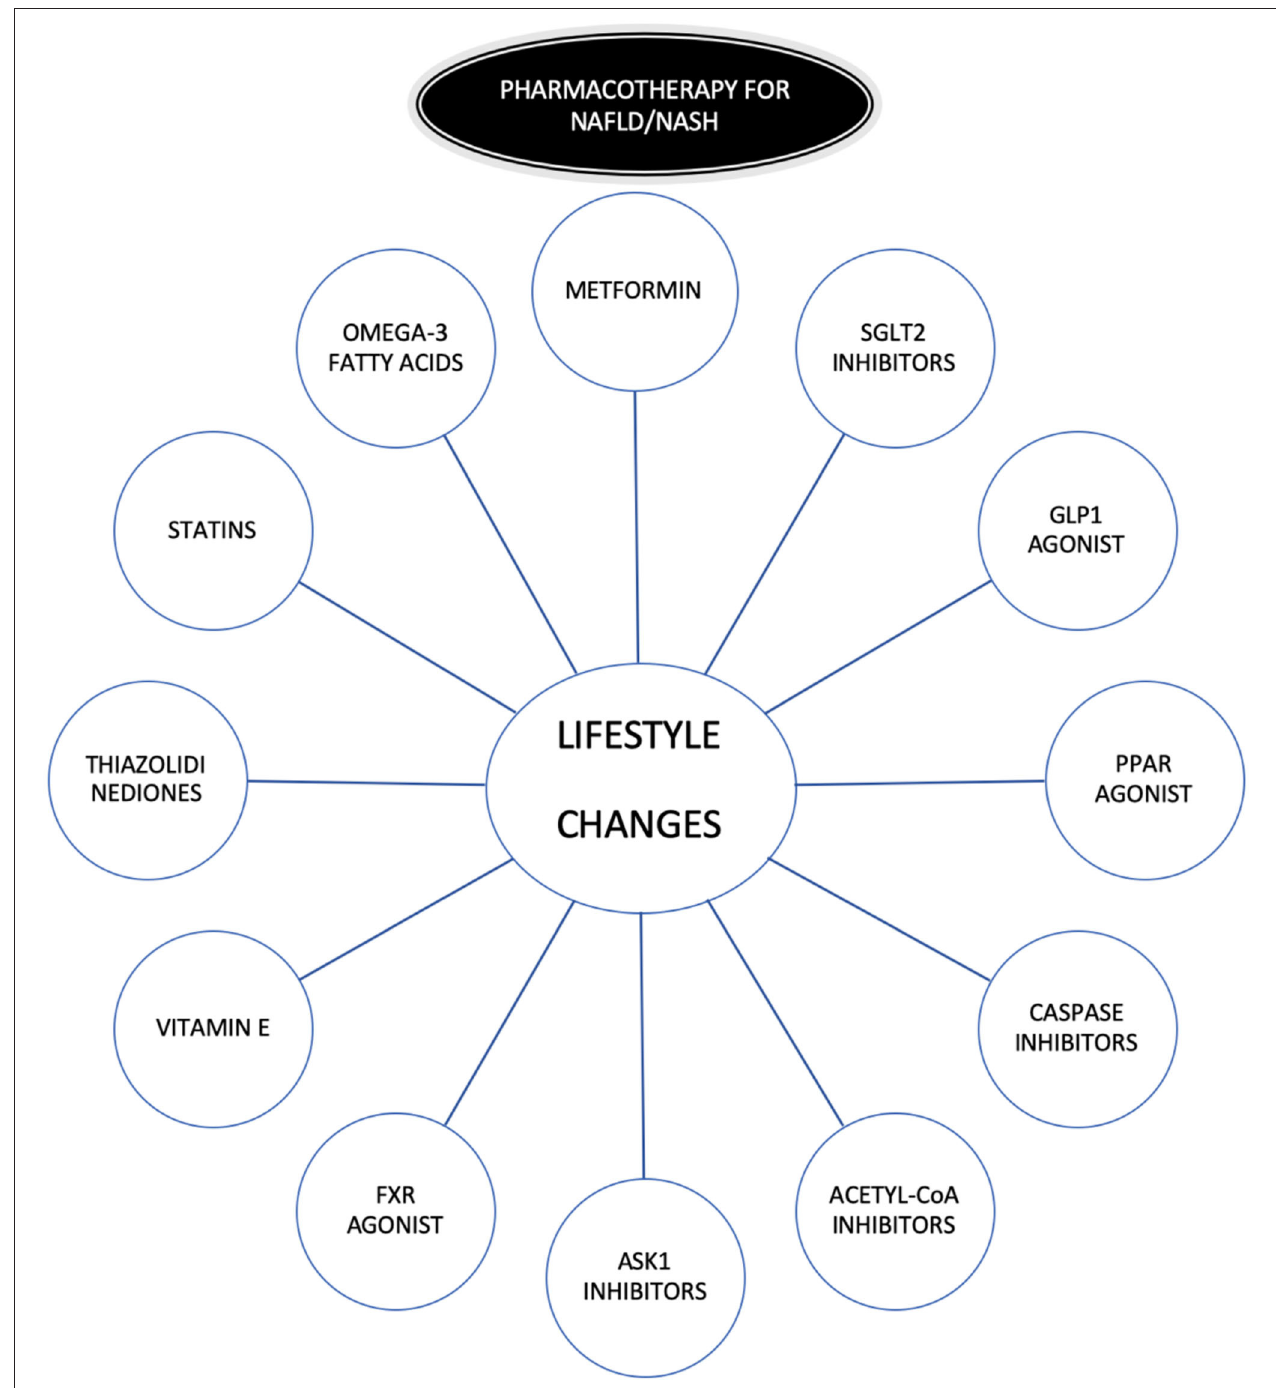
FIGURE 2 | Pharmacotherapy in NAFLD/NASH. GLP1, Glucagon-Like Peptide 1; SGLT2, Sodium-Glucose Cotransporter-2; PPAR, Peroxisome proliferator-activated-receptor; ASK1, Apoptosis Signal-Regulating Kinase 1; FXR, inhibitors and Farnesoid X Receptor.